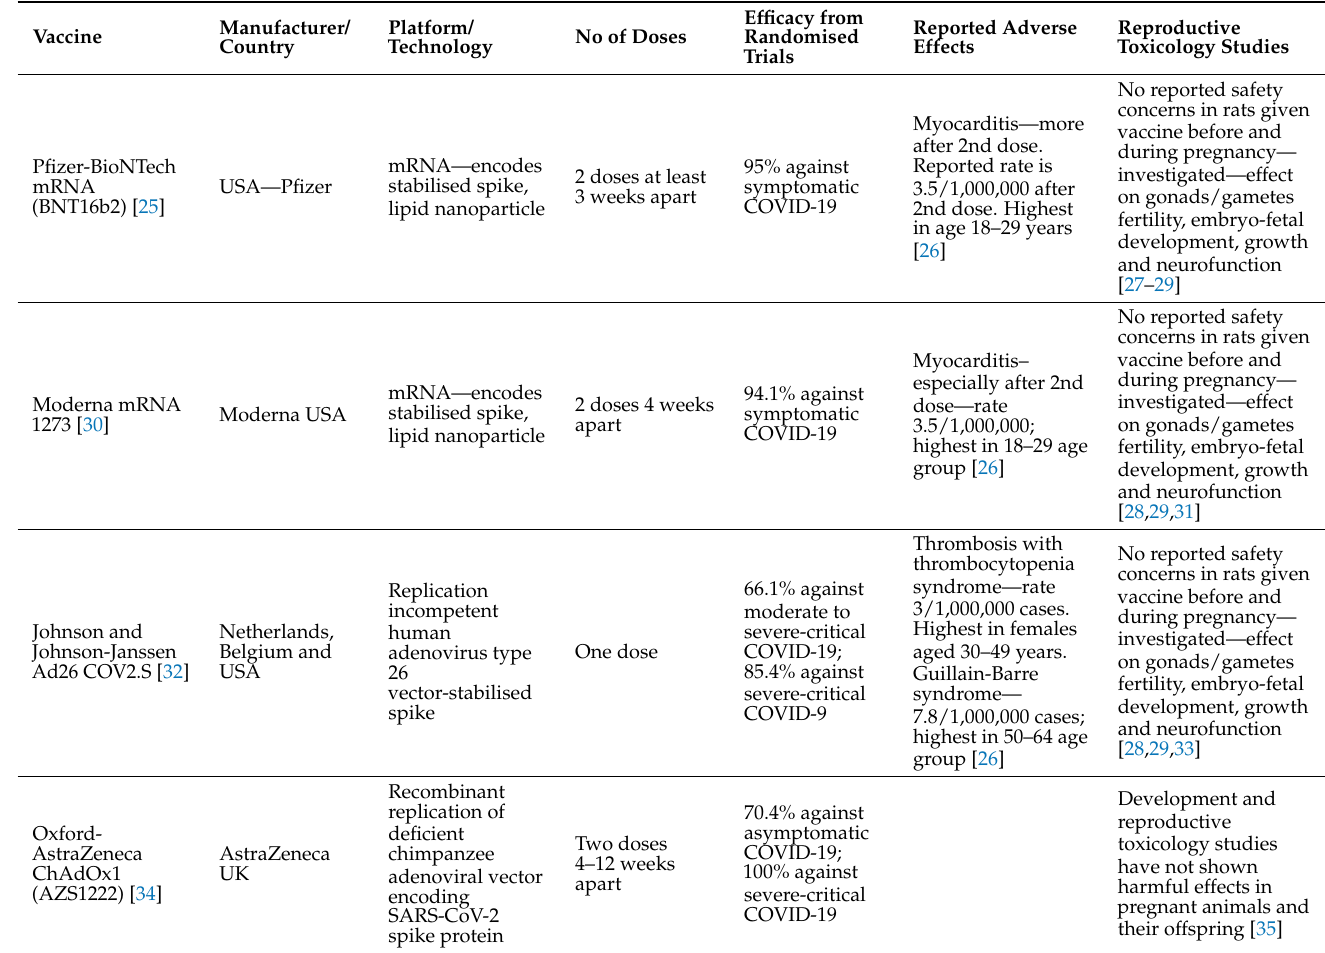
Table 1. Authorised vaccines for use in pregnancy, including their efficacy and